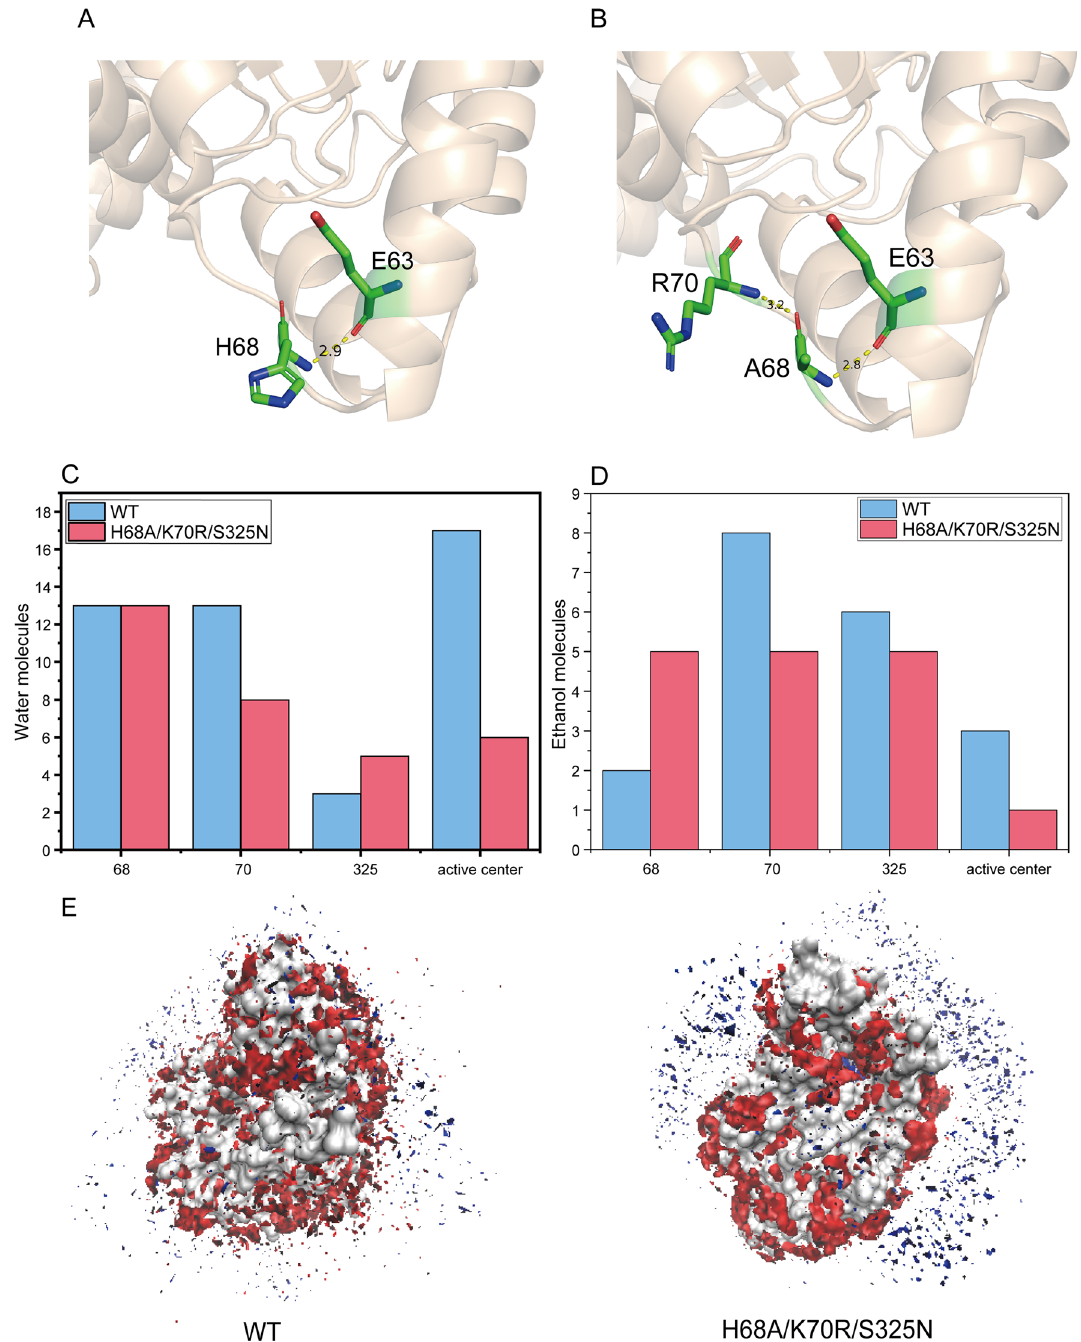
Fig. 4 Structural and simulation analysis of the triple mutant protein in the ethanol system. A Hydrogen bonds around WT mutation residue B Hydrogen bonds around mutation residue of the triple mutant C Water molecules near the mutation sites and active center D Ethanol molecules near the mutation sites and active center E Water molecules and ethanol molecules around the wild-type and triple mutant